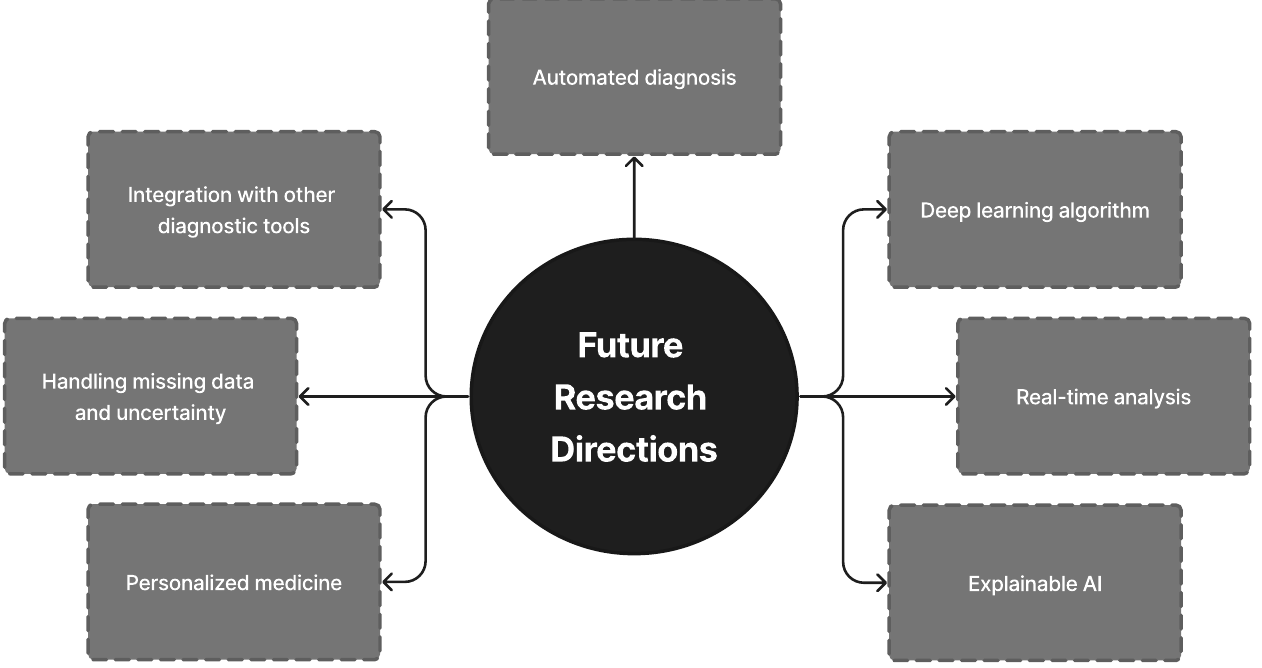
Figure 12. Future Research Directions for Oral Cancer Diagnosis .